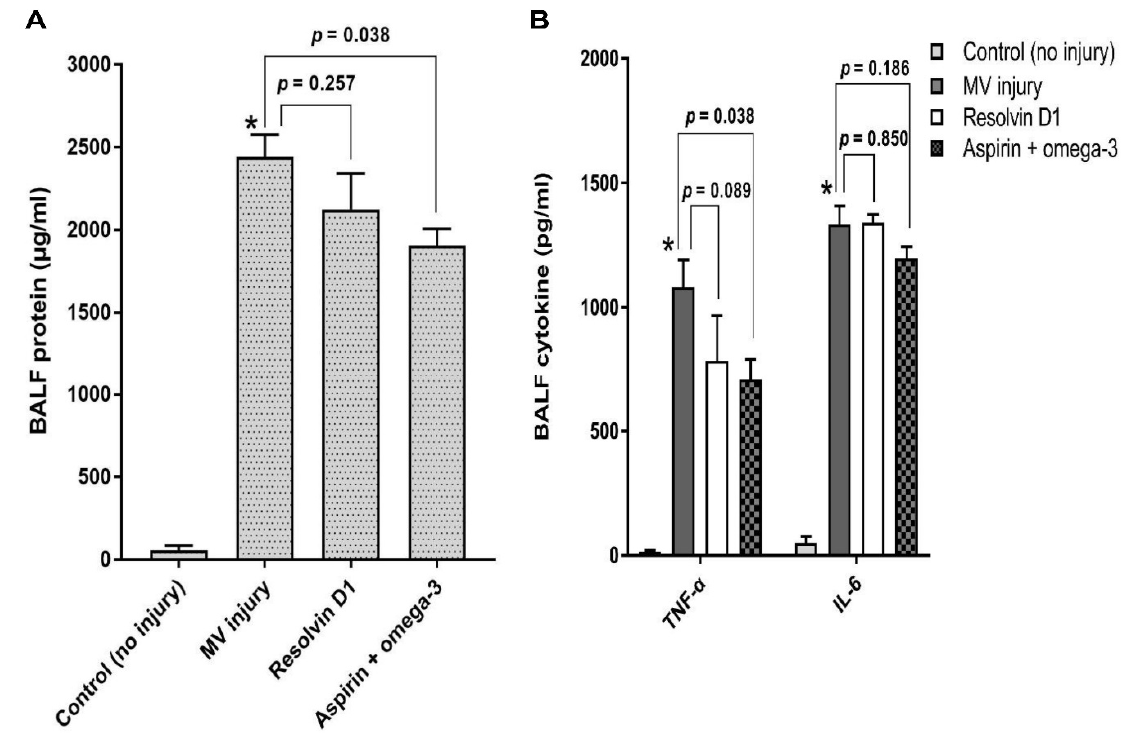
Figure 2. Total protein and cytokines analysis in bronchial alveolar lavage fluid for the effect of pretreatment. TNF- α and IL-6 levels were measured in the BALF after MV injury. The number of mice in the control (no injury), only injury, resolvin D1 pretreated, and aspirin and omega-3 pretreated groups were 3, 7, 4, and 4, respectively. Data are presented as mean ± standard error of the mean. * p < 0.05 for value between control group and injury only group. ( A ) BALF protein analysis. ( B ) BALF cytokine analysis. TNF- α , tumor necrosis factor- α ; IL-6, interleukin-6; BALF, bronchoalveolar lavage fluid; MV, mechanical ventilation.